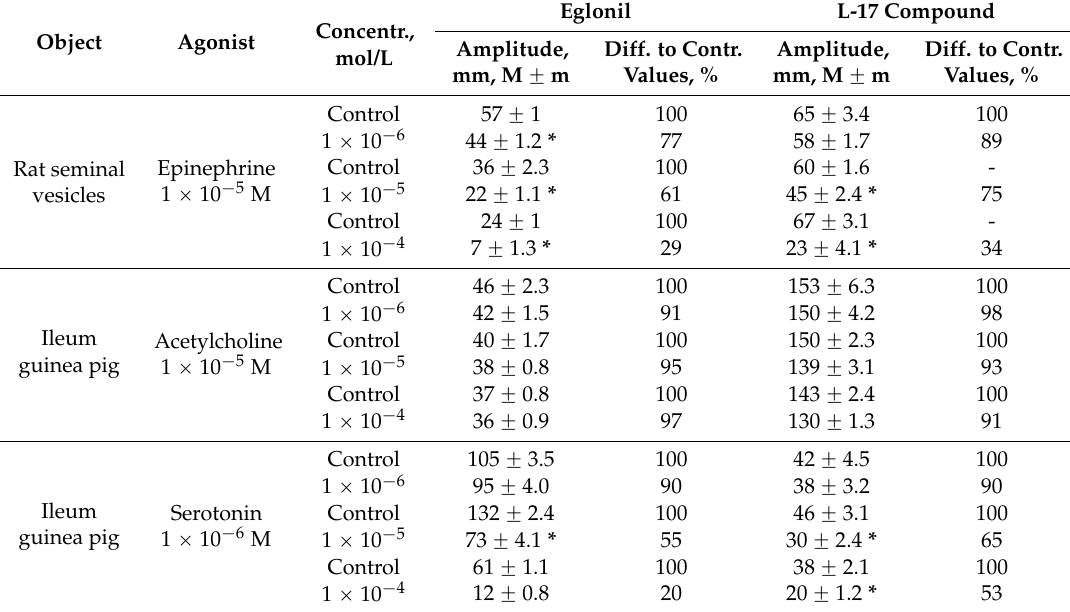
Table 7. The influence of compound L-17 on the contractile activity of isolated smooth muscles.